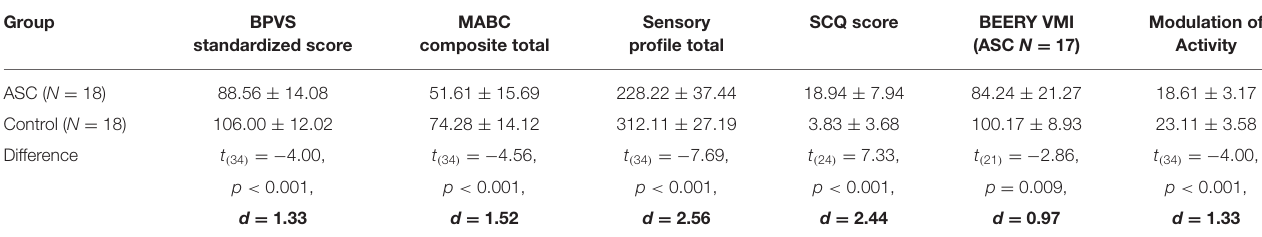
TABLE 2 | Dependent variable descriptives and comparison of